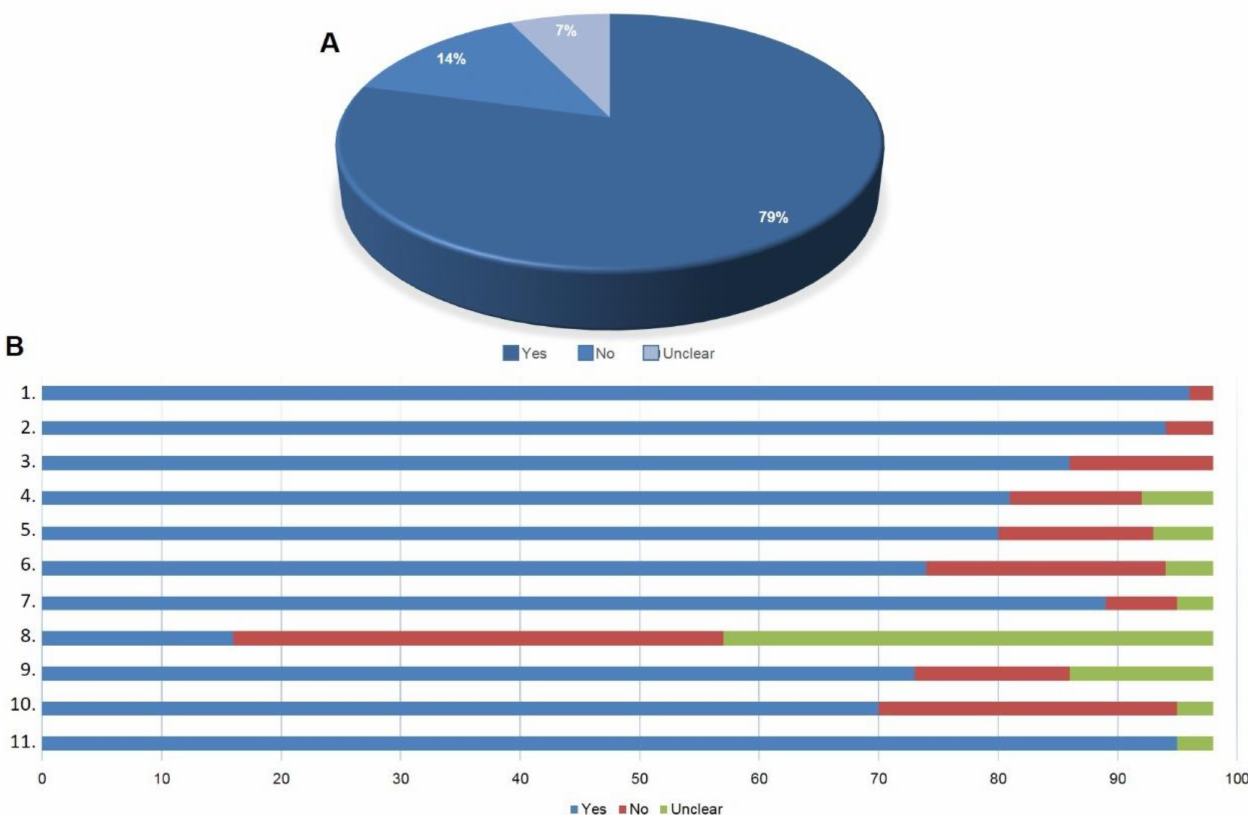
Figure 3. Analysis of the quality of the selected articles. ( A ) Overall retrieved articles. ( B ) Quality of the selected studies according to the eleven pre-defined assessment questions: 1. Was there a clear statement of the aims of the research? 2. Was the research design appropriate to address the aims of the research? 3. Was the execution of the methodologies described in sufficient detail to permit replication of the experiments? 4. Did the study provide a clear definition of what was considered to be a positive and negative control? 5. Have ethical issues been taken into consideration? 6. Was the data analysis sufficiently rigorous? 7. Was the study free of commercial funding? 8. Has the characterization of MSC been done according to ISCT criteria? 9. Were MSC used from the 2nd to the 5th passage in experiments? 10. Did MSCs demonstrate the potential for osteogenic, chondrogenic or adipogenic differentiation? 11. Did the research results show the potential of MSC in clinical applications? Yes (blue), No (red) and Unclear